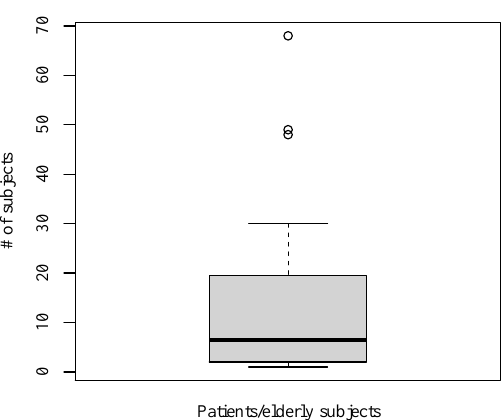
Figure 7. Distribution of number of patients and elderly